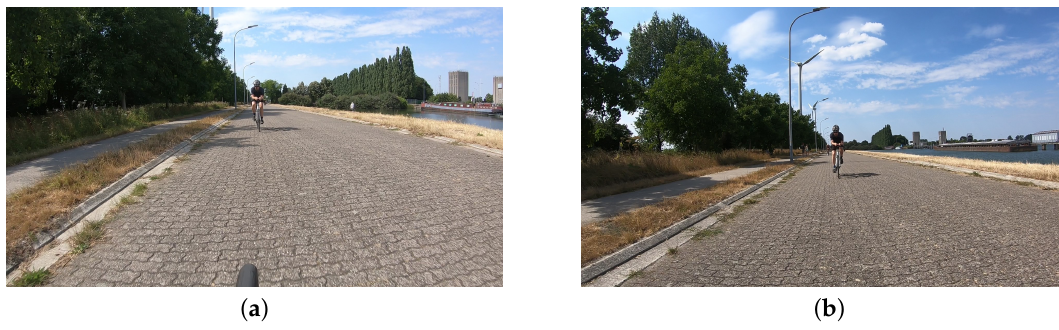
Figure 7. Example of an unwanted, significant change in tilt angle for one sequence, likely after hitting a rough road patch; ( a ) back wheel still visible; ( b ) back wheel no longer visible.